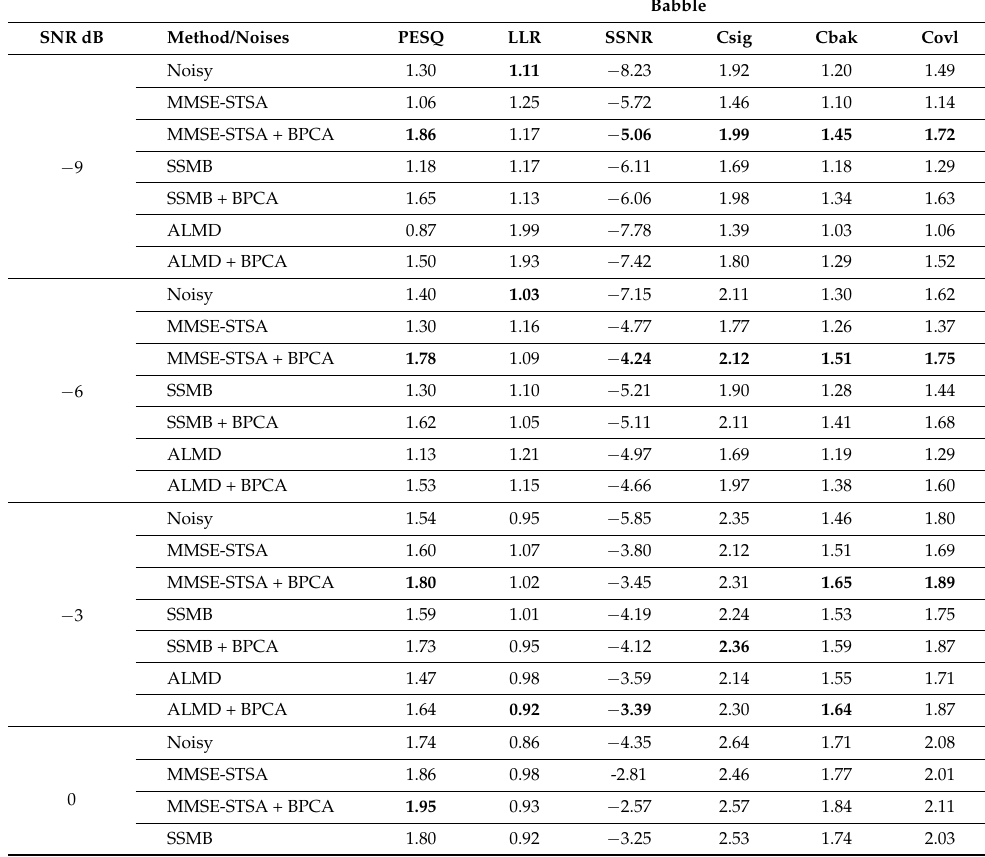
Table 3. All performance metric scores for noise type ‘Babble’ over multiple SNR levels. Best results are highlighted in bold